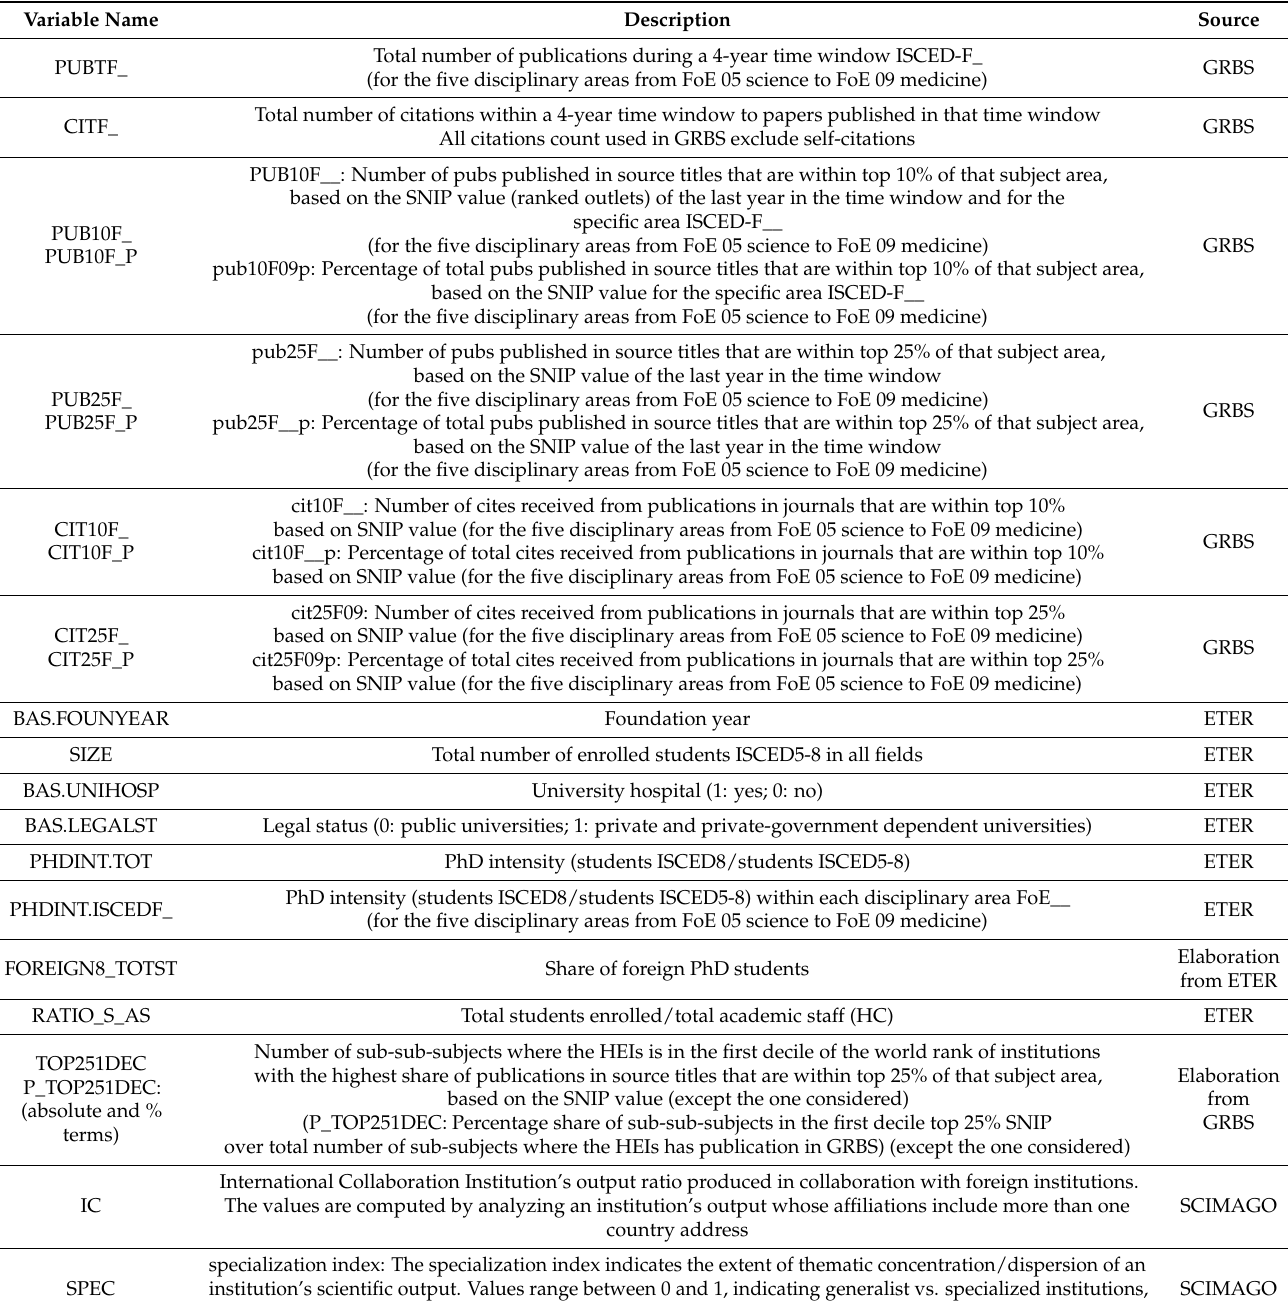
Table 1. Variables in the data set: definition and